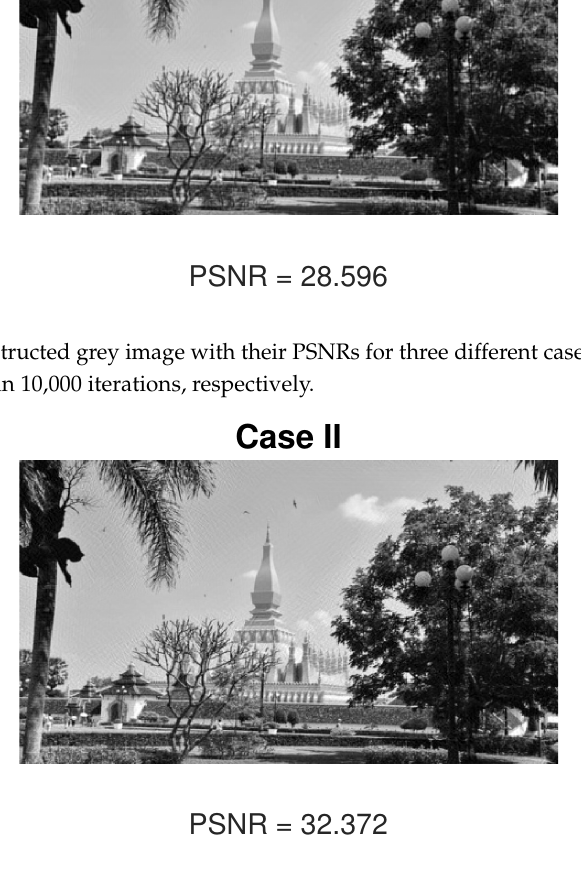
Figure 23. The reconstructed grey image with their PSNRs for three different cases using the proposed algorithm presented in 10,000 iterations, respectively.